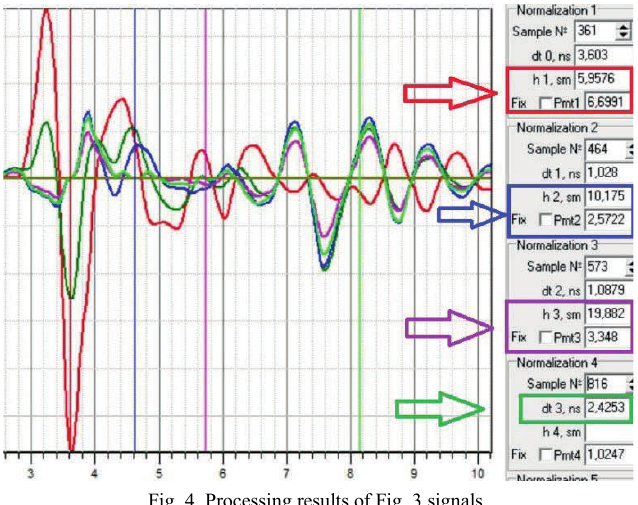
Fig. 4. Processing results of Fig. 3 signals.